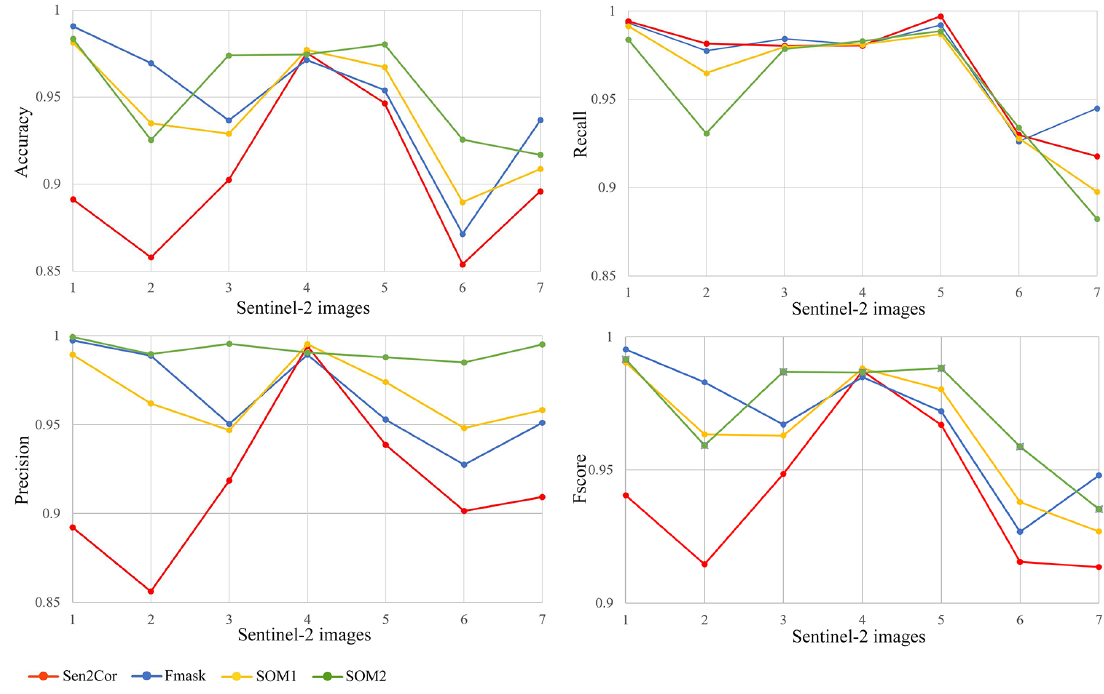
Figure 14. Evaluation metrics of the Sentinel-2 images with bright non-cloud objects.